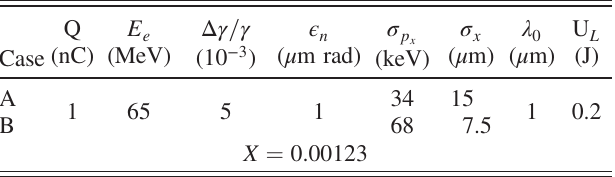
TABLE I. Interaction parameters for STAR. σ L ¼ 15 μ m, σ t ¼ 1 ps and σ p x electron beam rms transverse momentum (keV).